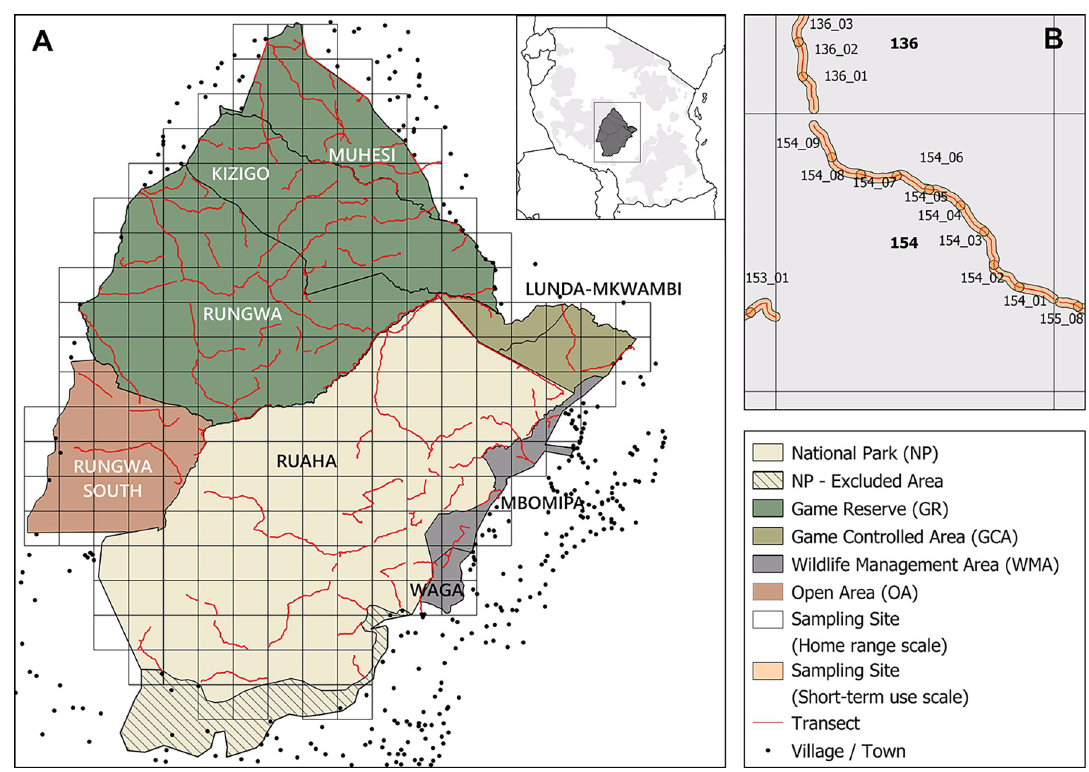
Fig 1. The Ruaha-Rungwa conservation landscape (A), within the wider context of Tanzania’s protected area system (inset). A: Sampling grid investigating co-occurrence at the home range scale; B: Sampling grid investigating co-occurrence at the short-term use within the home range scale. Sampling sites consist of 225 km 2 grid cells at the home range scale, and of an area of ~1 km 2 around 2 km survey transect segments at the short-term use scale. Both the gazetted and effective boundaries for Ruaha NP are depicted. Lunda- Mkwambi GCA comprises both Lunda-Mkwambi North and South, while Rungwa South OA comprises both Rungwa South OA and Rungwa Mzombe OA. Only villages in proximity of the PA complex are shown.